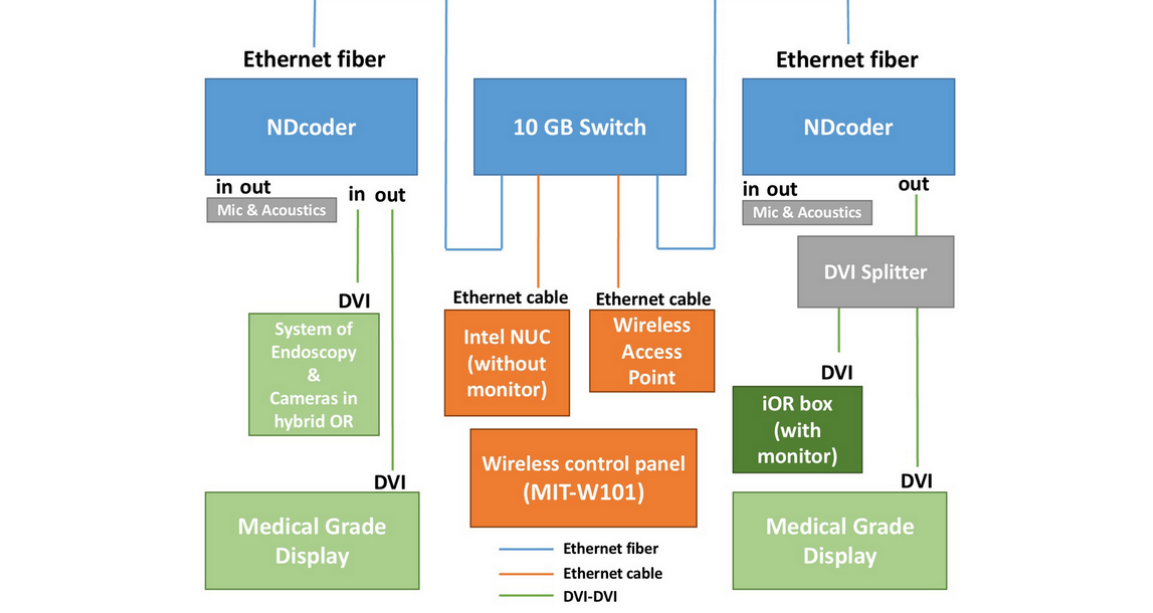
Real-Time Streaming Under Specific